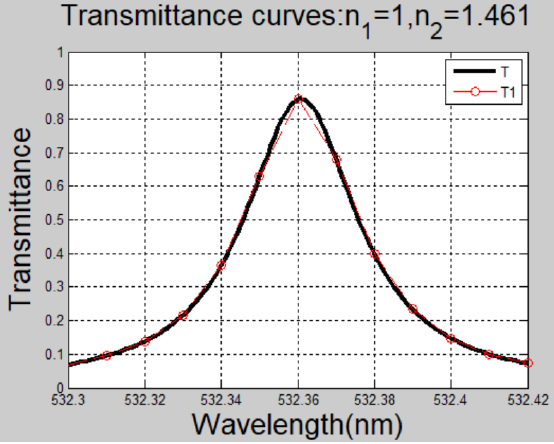
Figure 7 Theoretical transmittance curve comparison